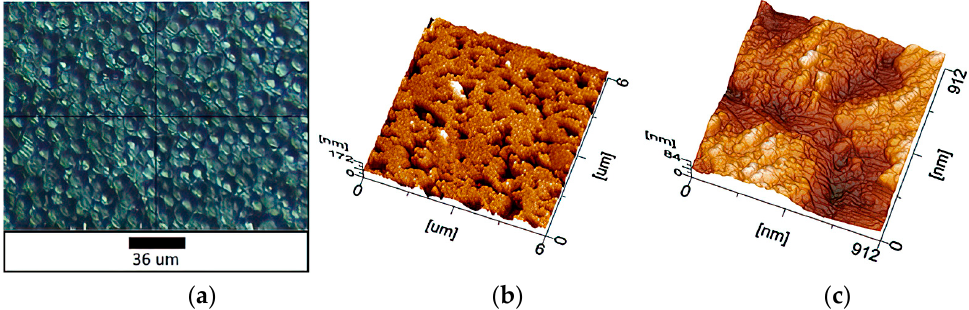
Figure 1. AFM images of the sample without coating: ( a ) optical microscopy; ( b ) 6 × 6 μ m (topog- raphy mode); ( c ) 912 × 912 nm (topography mode).